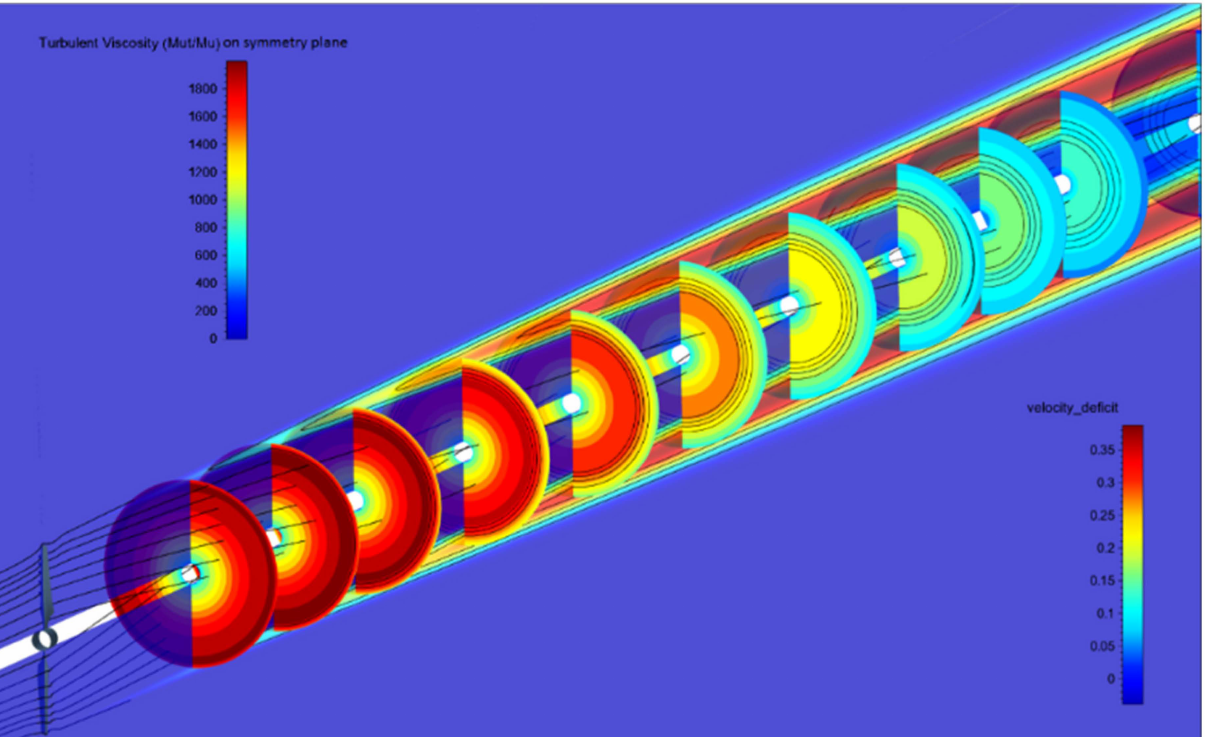
turbulent viscosity ratio in the Y symmetry plane. A similar effect is seen where the increase